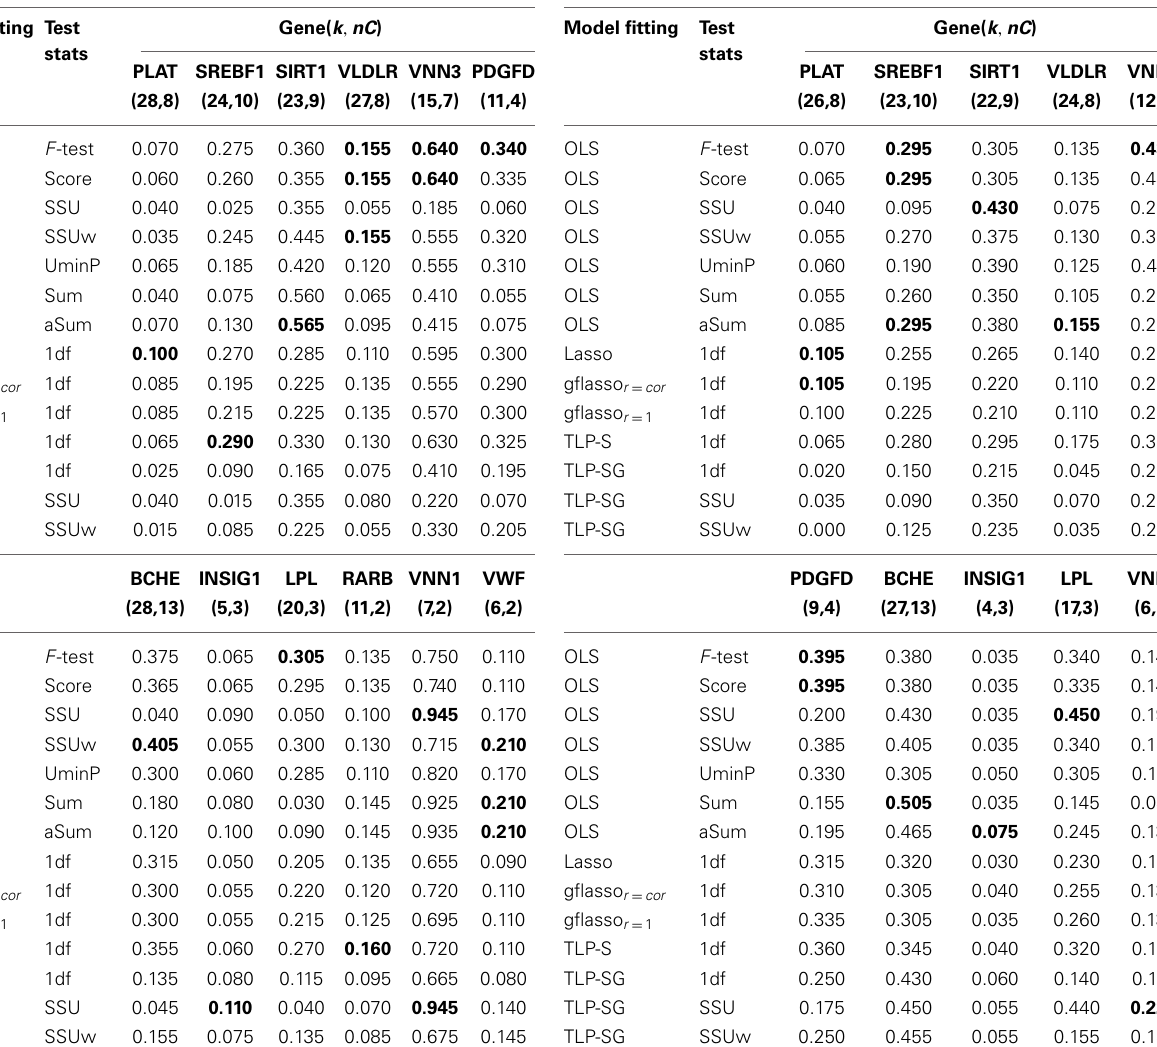
Table 6 | Empirical power based on the GAW17 data from 200 replicates of Q2, k , and nC denote the numbers of the total and causal variants in a gene.